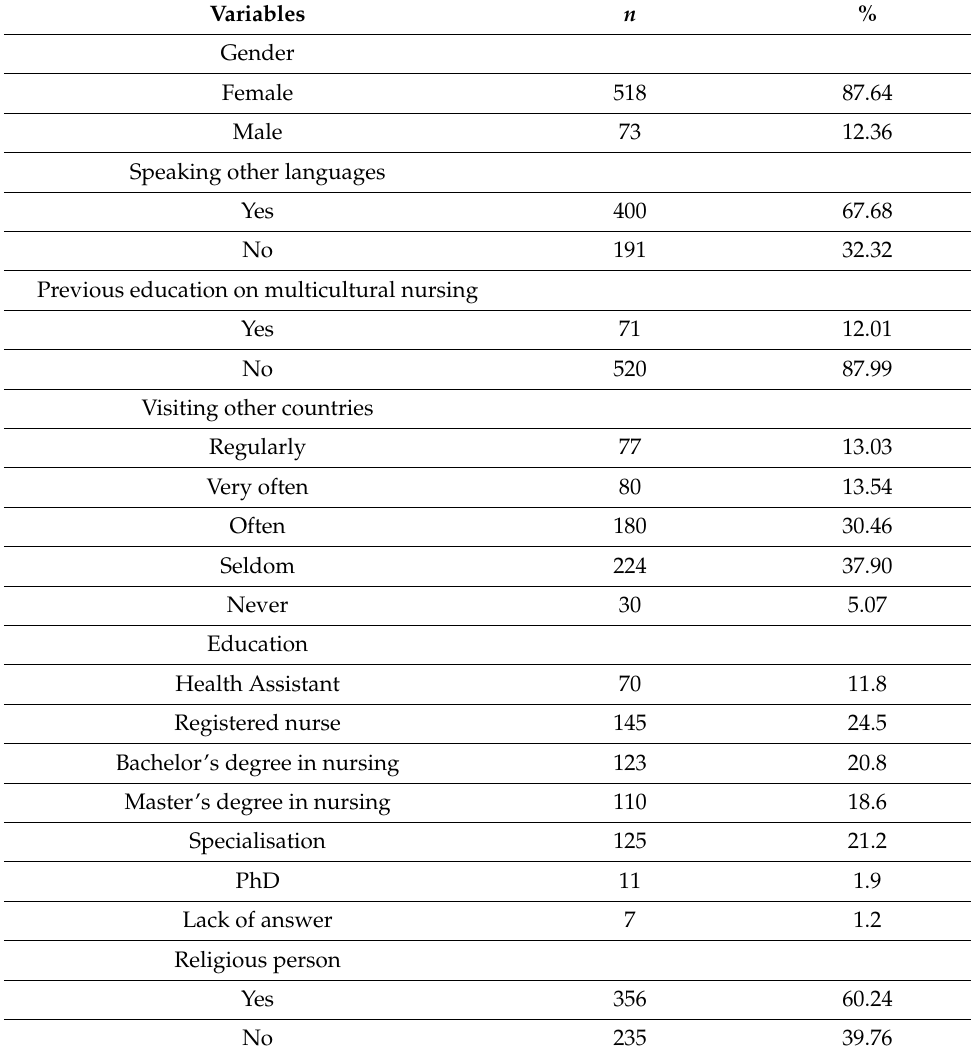
Table 1. Table 1. Sociodemographic characteristics of the surveyed nurses ( n =